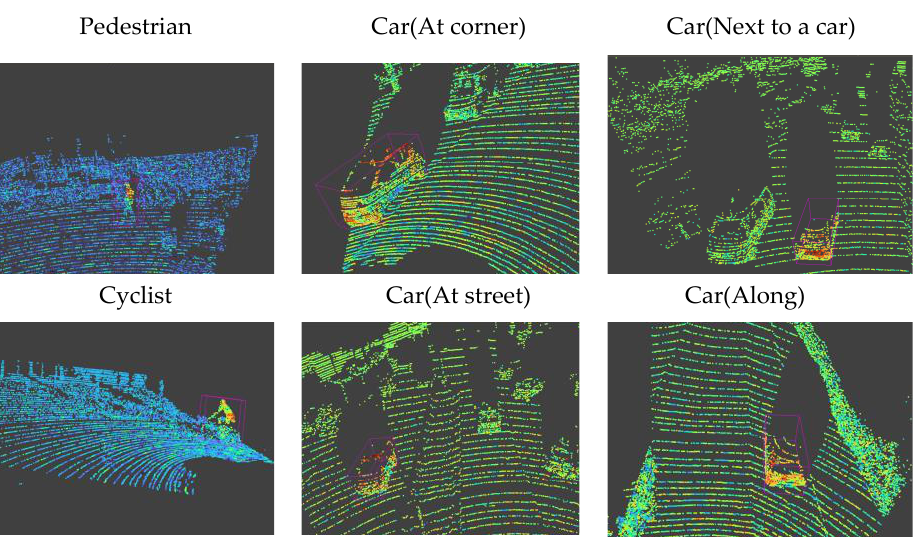
Figure 1. Attribution map examples for 3DSSD [13] detections on KITTI. Warmer colours (turbo colormap) denote higher contribution of a point to this detection.